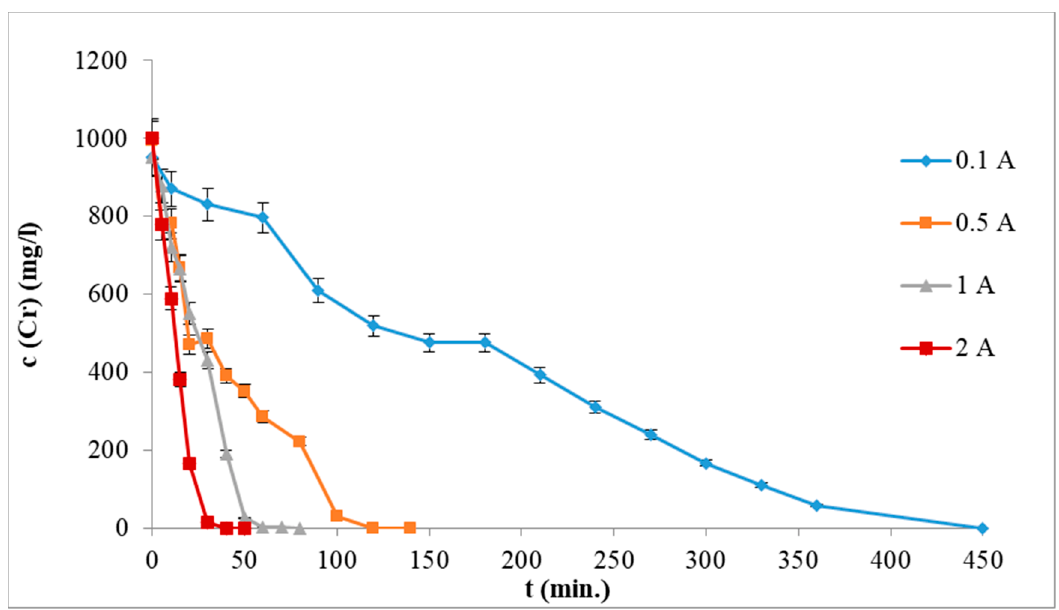
Figure 3. Decrease of Cr concentration for different current intensities, model solution, c (NaCl) = 3000 Figure3. DecreaseofCrconcentrationfordifferentcurrentintensities,modelsolution,c (NaCl) = 3000 mg / L, mg/L, pH = 6. pH =